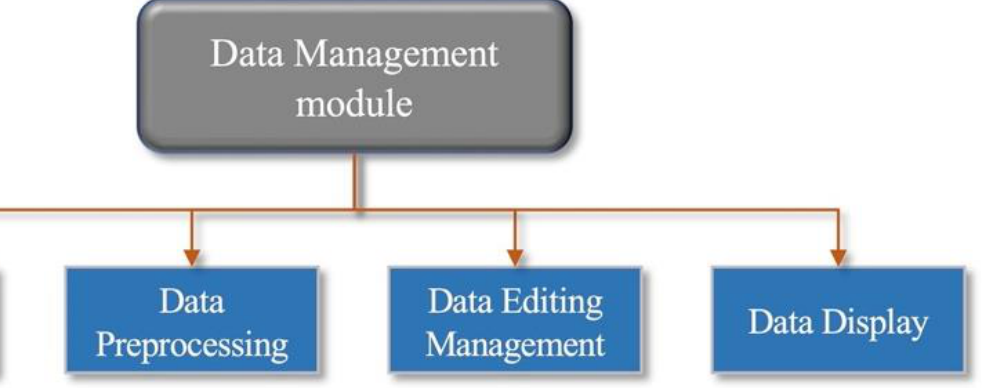
Figure 2. Data management module framework.